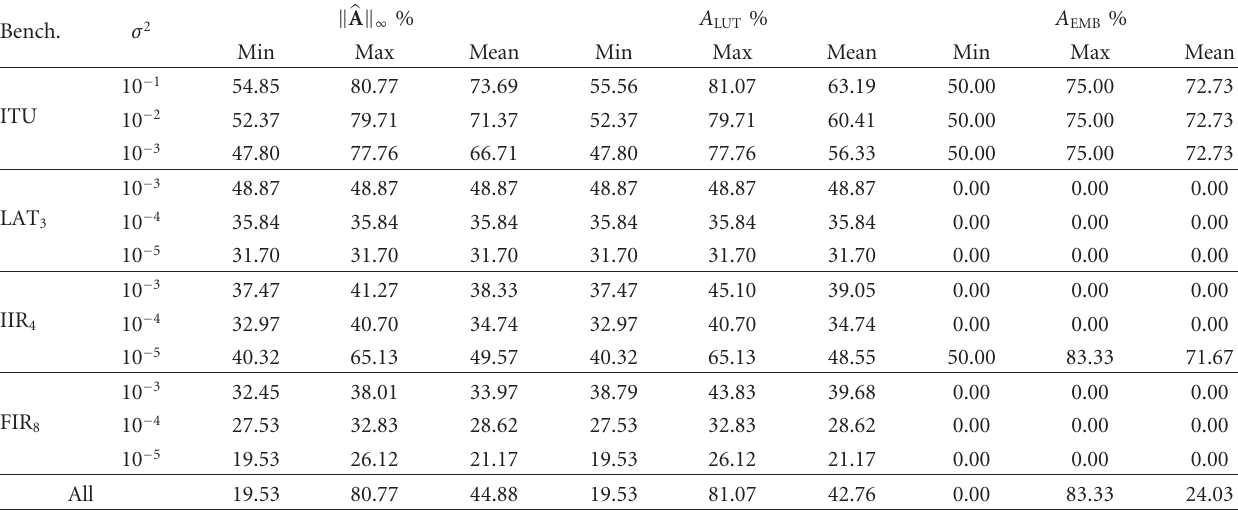
Table 4: UWL versus MWL for heterogeneous architectures.